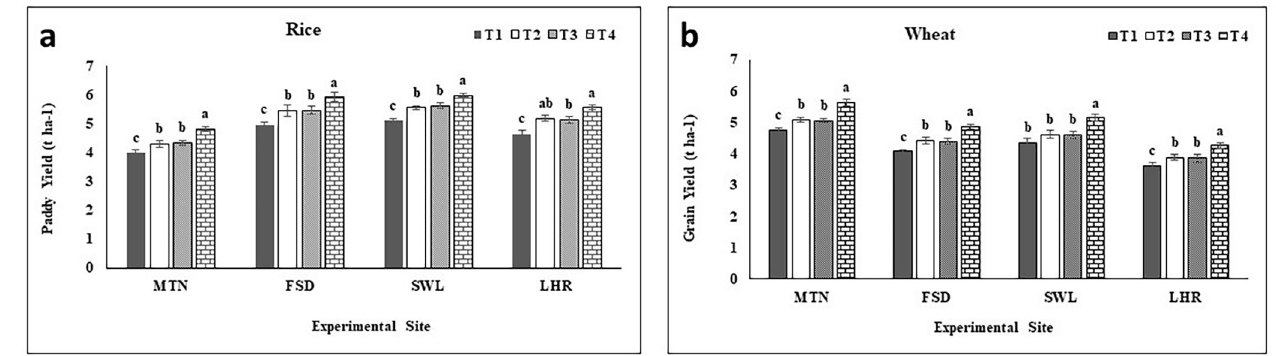
Fig 1. Effect of zinc sulfate and bioactive zinc coated urea on paddy yield of rice and wheat grain yield. MTN = Multan; FSD = Faisalabad; SWL = Sahiwal; LHR = Lahore; BAZU = Bioactive Zn coated urea (42% N; 1% Zn); T 1 (Urea 46% N @ 185 kg ha -1 + zero Zn), T 2 (Urea 46% N @ 185 kg ha -1 + ZnSO 4 33% Zn @ 15 kg ha -1 ), T 3 (BAZU 42% N @ 100 kg ha -1 + Urea 46% N @ 62 kg ha -1 + 1% bioactive Zn @ 1.00 kg ha -1 ), T 4 (BAZU 42% N @ 125 kg ha -1 + Urea 46% N @ 62 kg ha -1 + 1% bioactive Zn @ 1.25 kg ha -1 ).